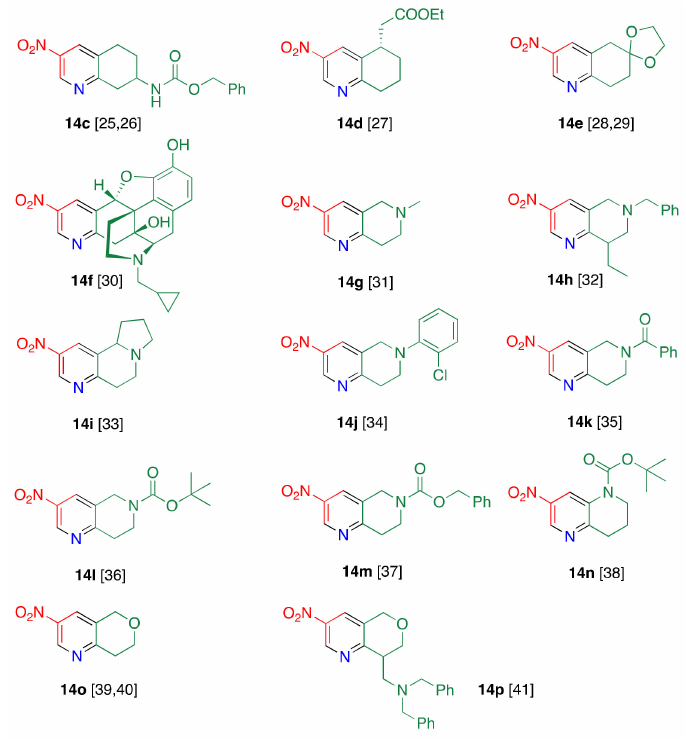
Figure 2. Nitropyridines condensed with a six-membered